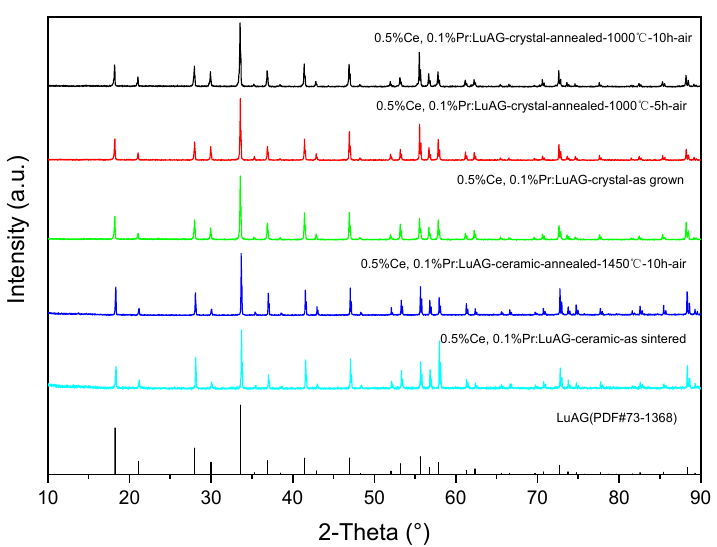
Figure 2. XRD patterns of the as grown Ce, Pr:LuAG crystal powders and bulk ceramic.